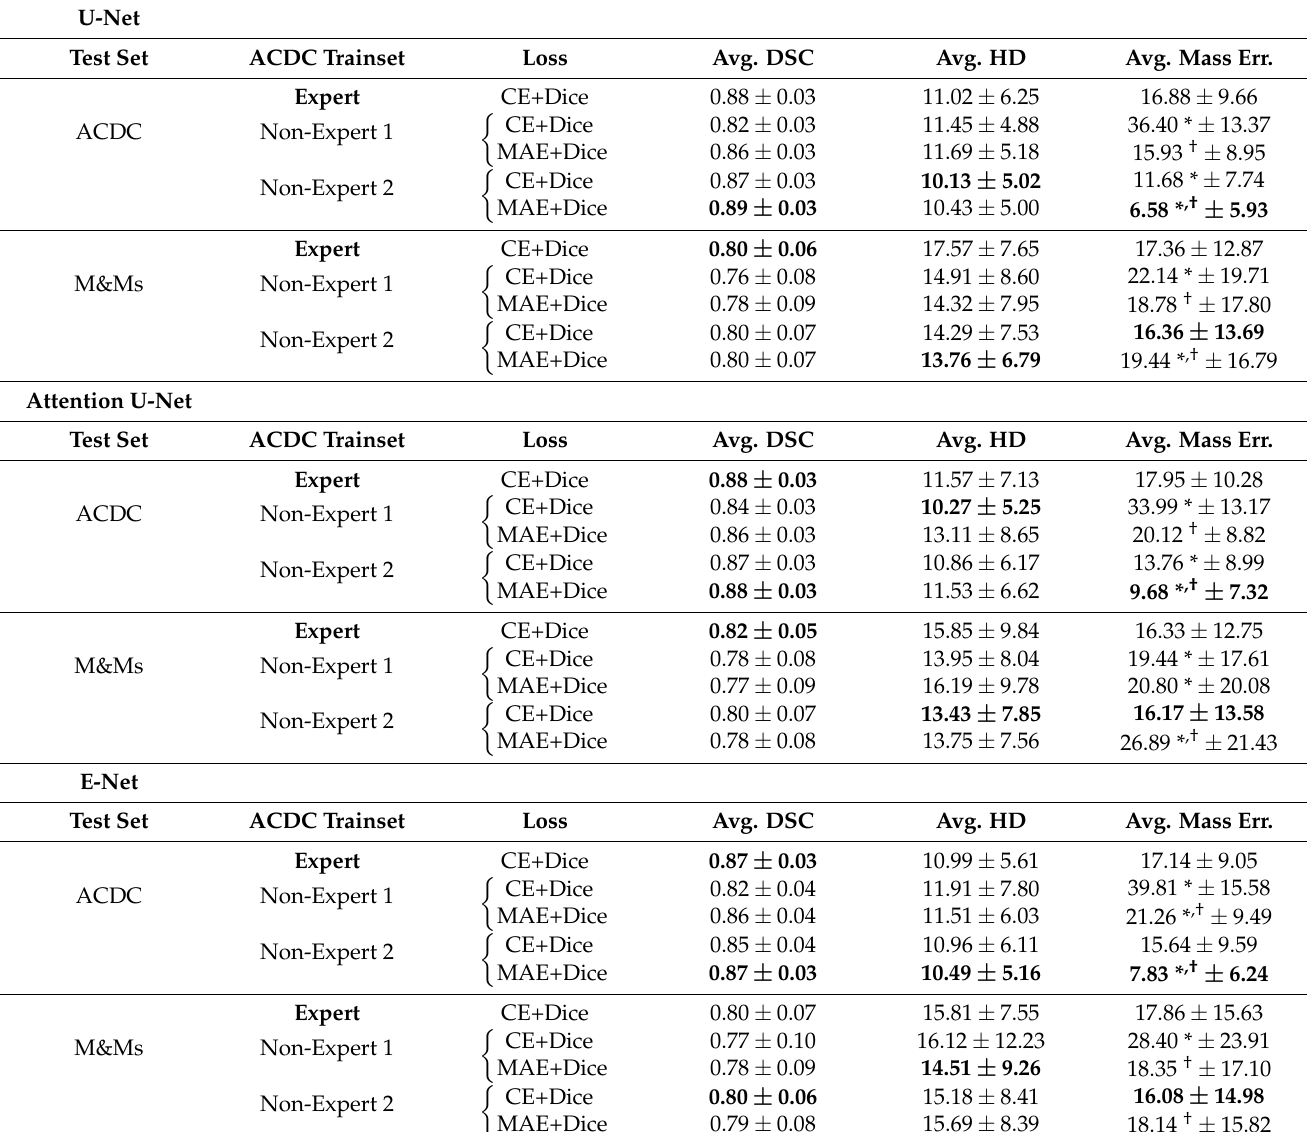
Table 2. Dice score, Hausdorff distance and mass error for the myocardium for U-Net, Attention U-Net and E-Net with expert and non-expert annotations with data